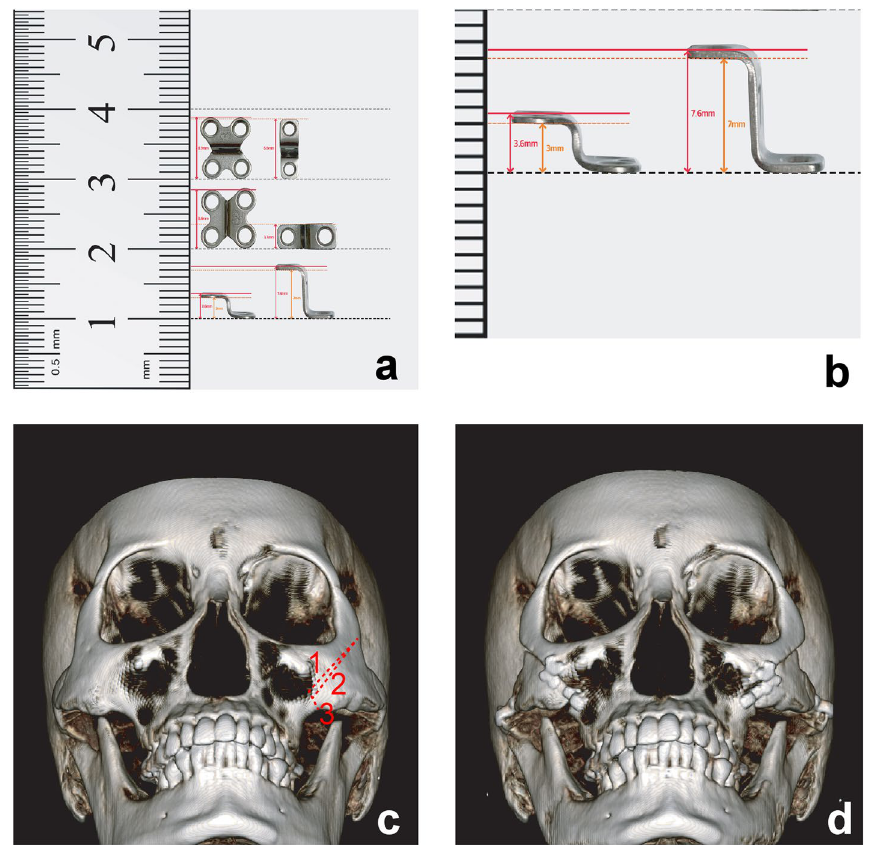
Fig. 1 Degree of plate bending and segmentation. a Four-hole plate for the eminence and two-hole plate for the arch. b Measurement of bending degree. c , d Degree of eminence segmentation, indicated by the linear distance between osteotomies 1 and 2 at the intersection with the cut